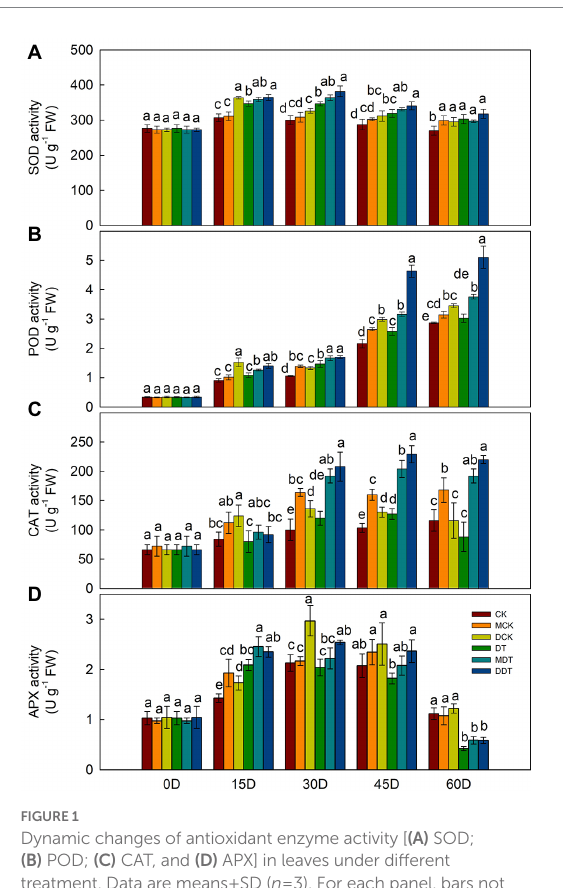
FIGURE 1 Dynamic changes of antioxidant enzyme activity [ (A) SOD; (B) POD; (C) CAT, and (D) APX] in leaves under different treatment. Data are means ± SD ( n = 3). For each panel, bars not labeled with same letter indicate significant differences at p < 0.05, based on Tukey’s multiple range